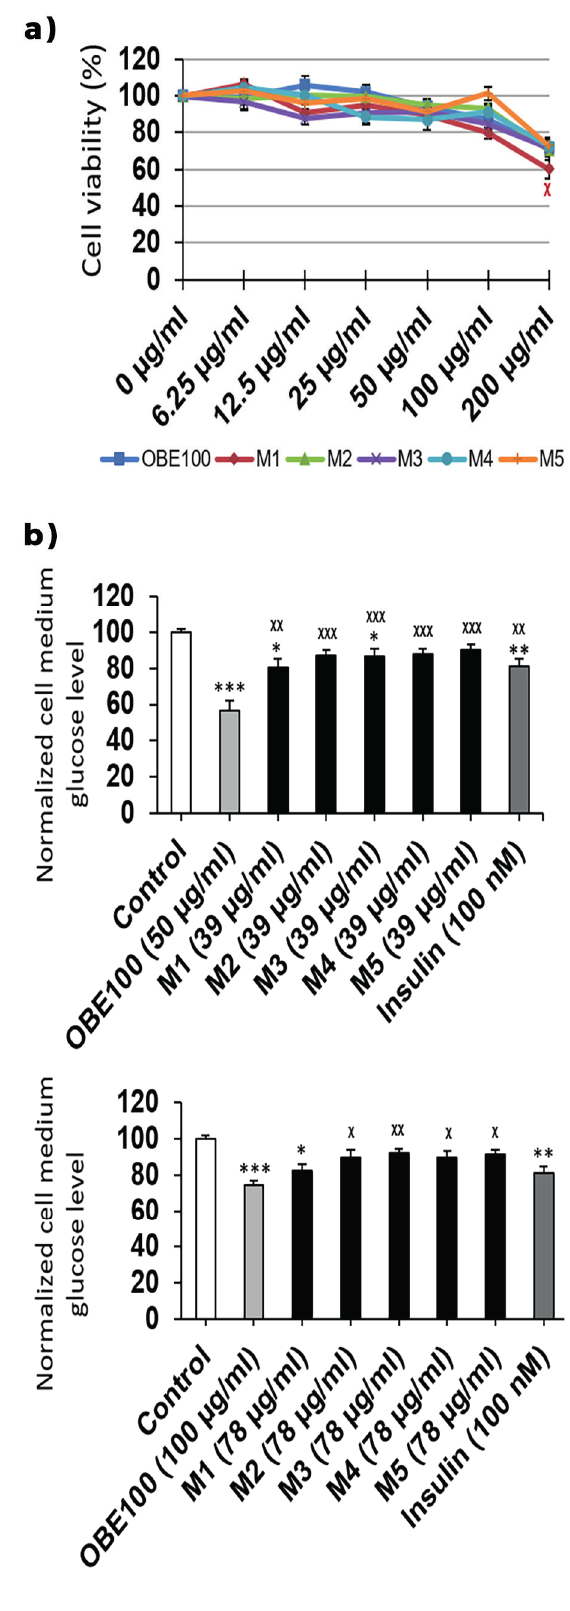
Figure 4. Effect of triterpenoid mixtures on cell viability and glucose uptake in C2C12